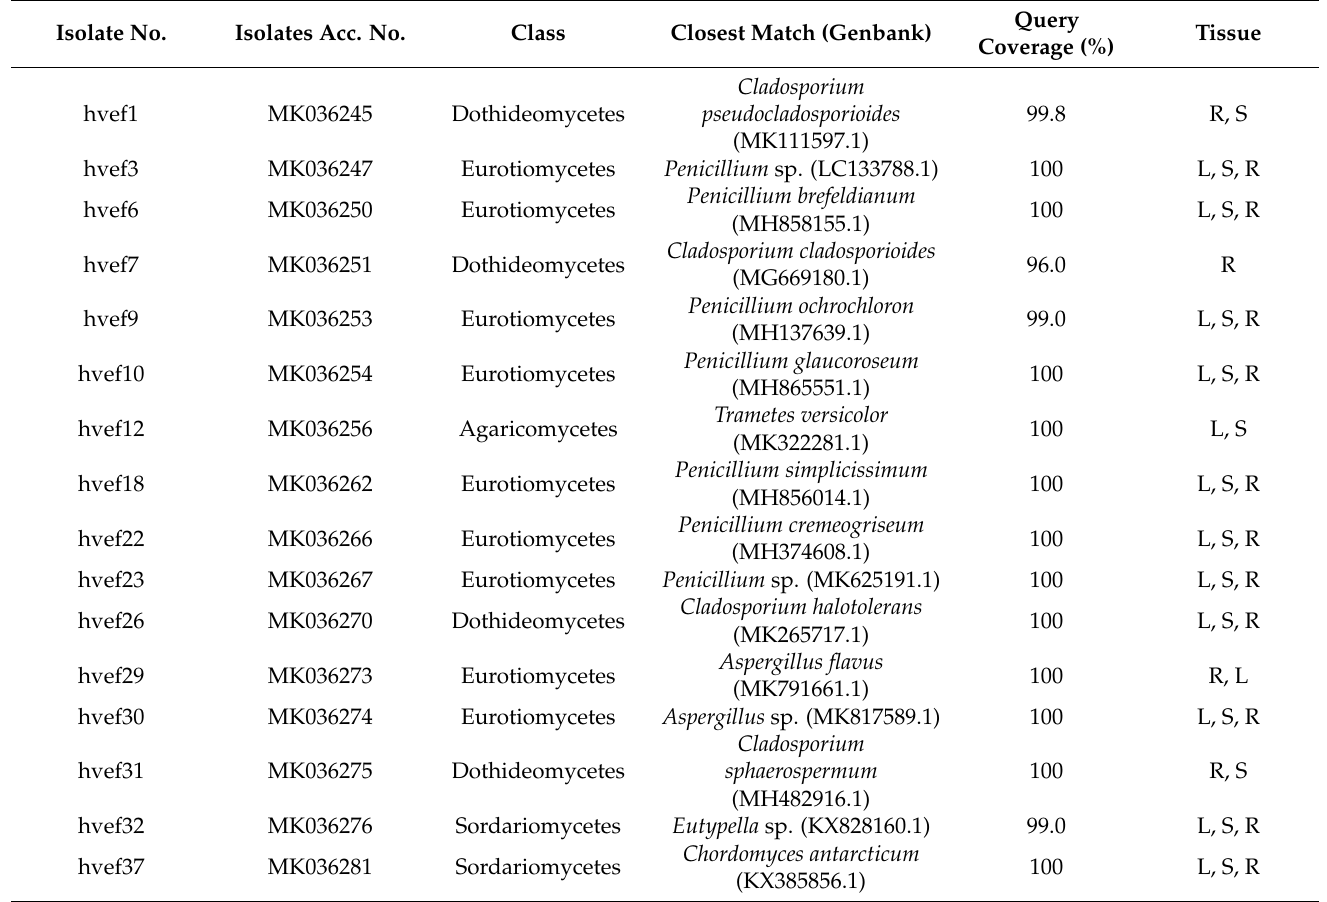
Table 1. Taxonomic classification of fungal endophyte OTUs from ITS sequences of endophytic fungi recovered from three representative tissues of hairy vetch with NCBI accession numbers. Isolate No. Isolates Acc.